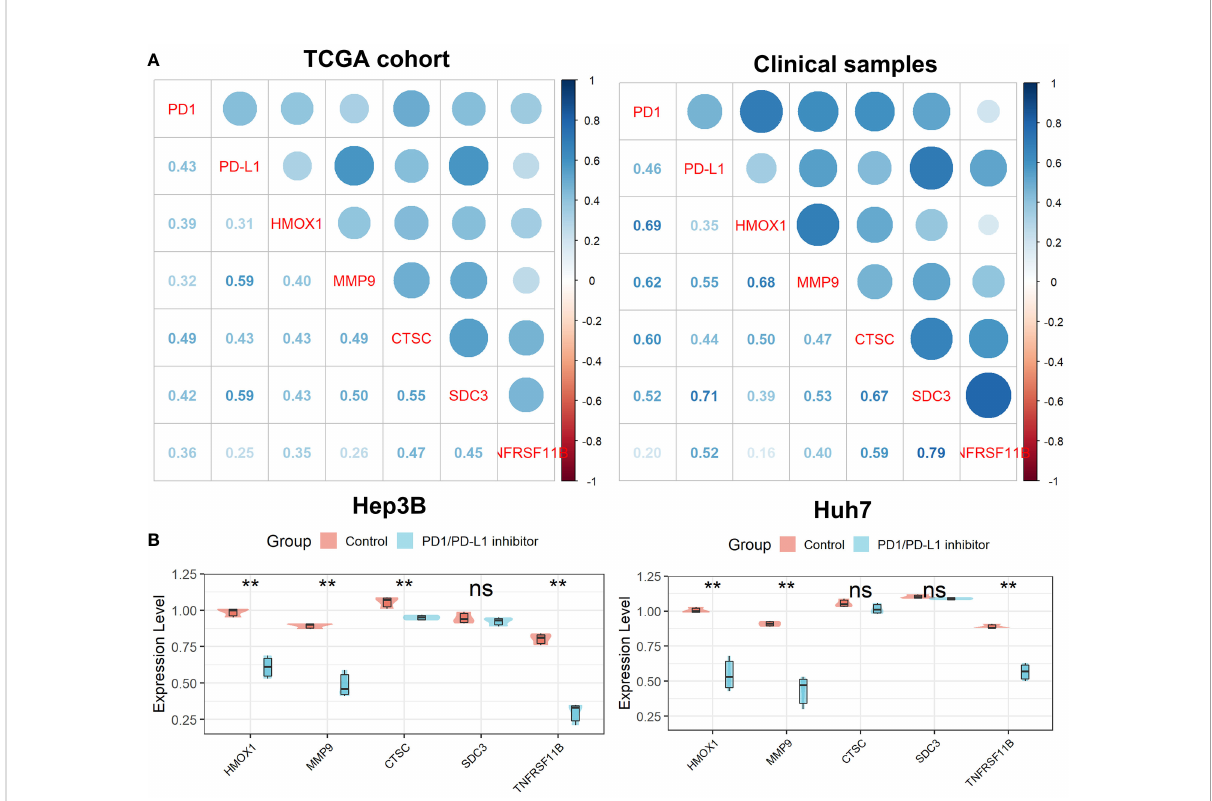
FIGURE 11 Veri fi cation of the Tregs-related signature after PD-L1 blockade. (A) All fi ve Tregs-related genes were related to PD1 and PD-L1 expression. (B) Differential expression of the fi ve Tregs-related genes after PD-L1 blockade. ns, not signi fi cant; **p